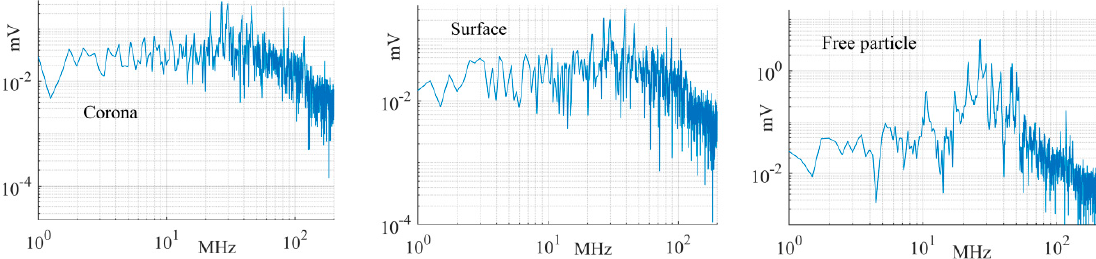
Figure 22. Frequency spectra of the largest signals measured by the antenna at position 1.